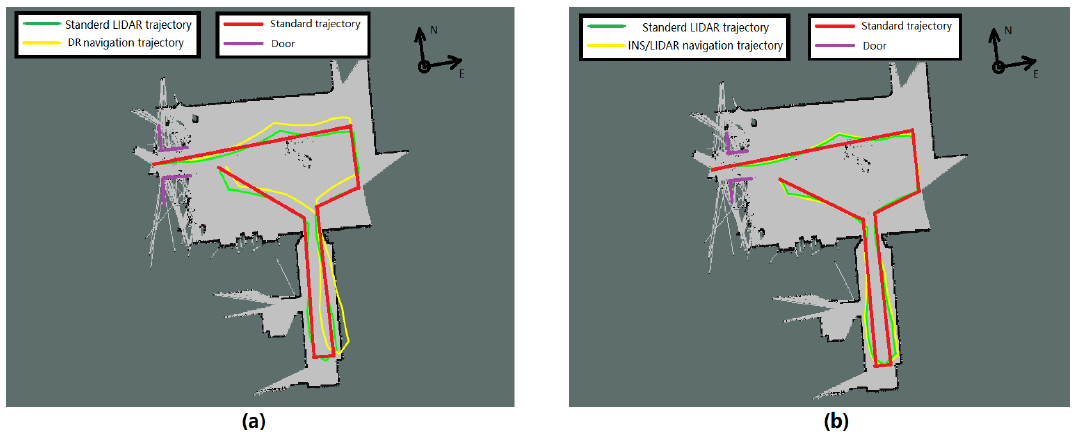
Figure 9. The comparison trajectory map of the integrated navigation algorithm in the second experiment (the second part of the experiment 2). ( a ) The DR indoor navigation algorithm trajectory map ( b ) The INS/LIDAR indoor integrated navigation algorithm trajectory